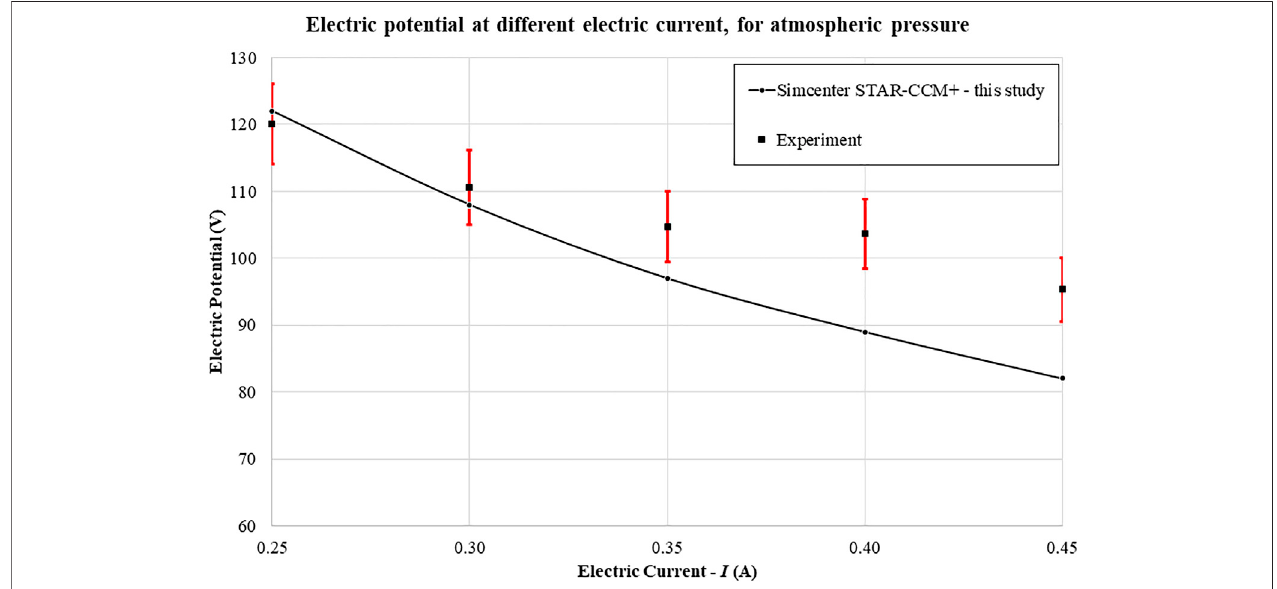
FIGURE 10 | Temperature in the x axis direction at the center of the inter-electrode gap ( t (cid:2) 50 ms, p (cid:2) 0.1 MPa, I (cid:2) 0.35 A).